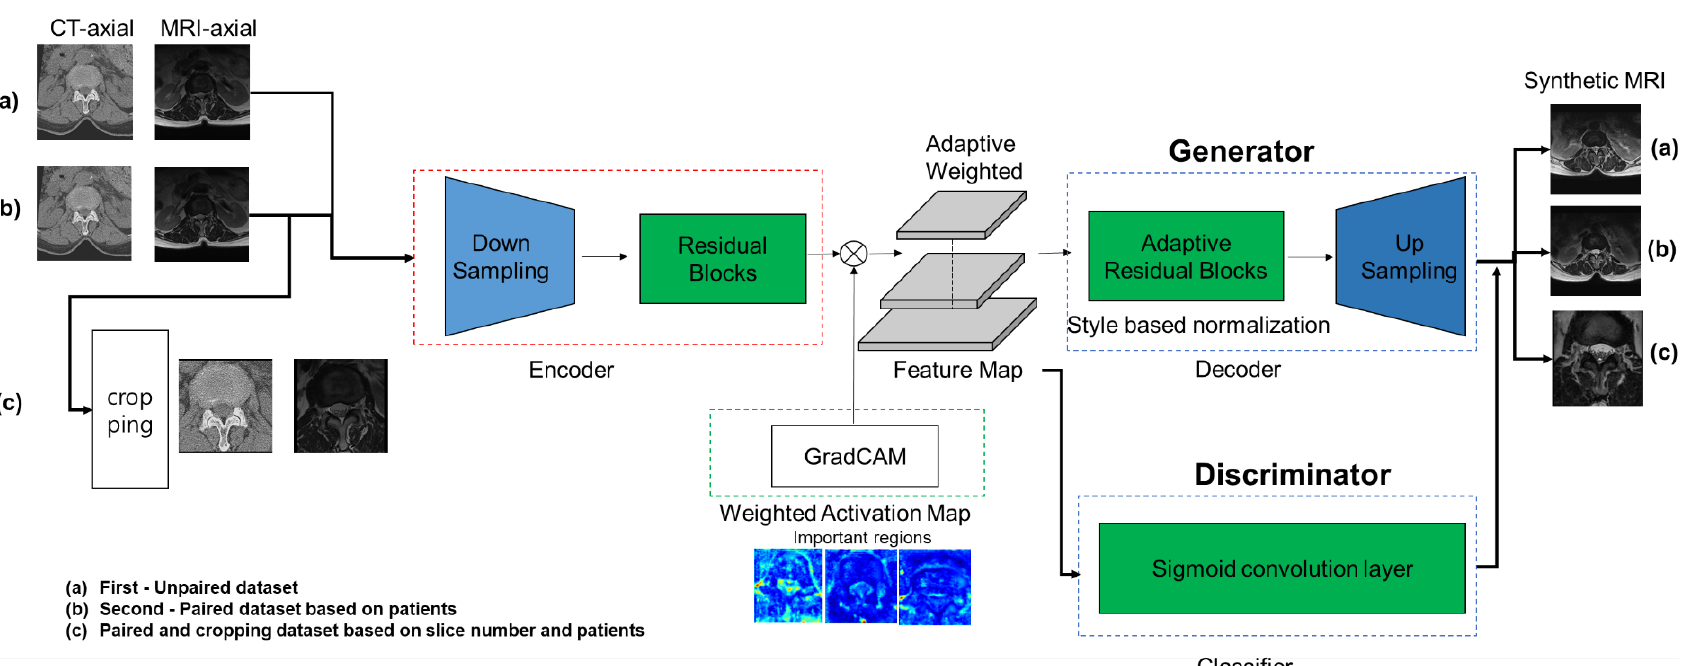
Figure 1. Model architecture for generating synthetic lumbar MRI from real lumbar axial CT images. The detailed explanation is described in the general architecture. MRI, magnetic resonance imaging; CT, computed tomography.